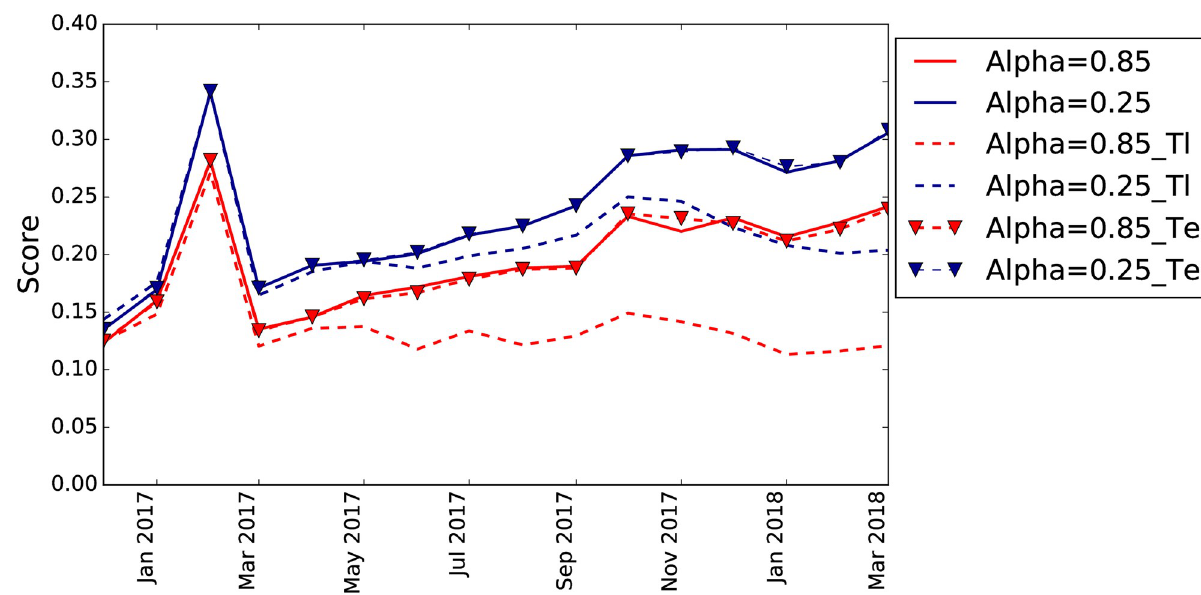
Fig 9. Recall@5% for the network model using different temporal discounting for the restart vector Q . The dashed lines correspond to the linear discount while the dashed lines with triangular markers to the exponential temporal discounting.